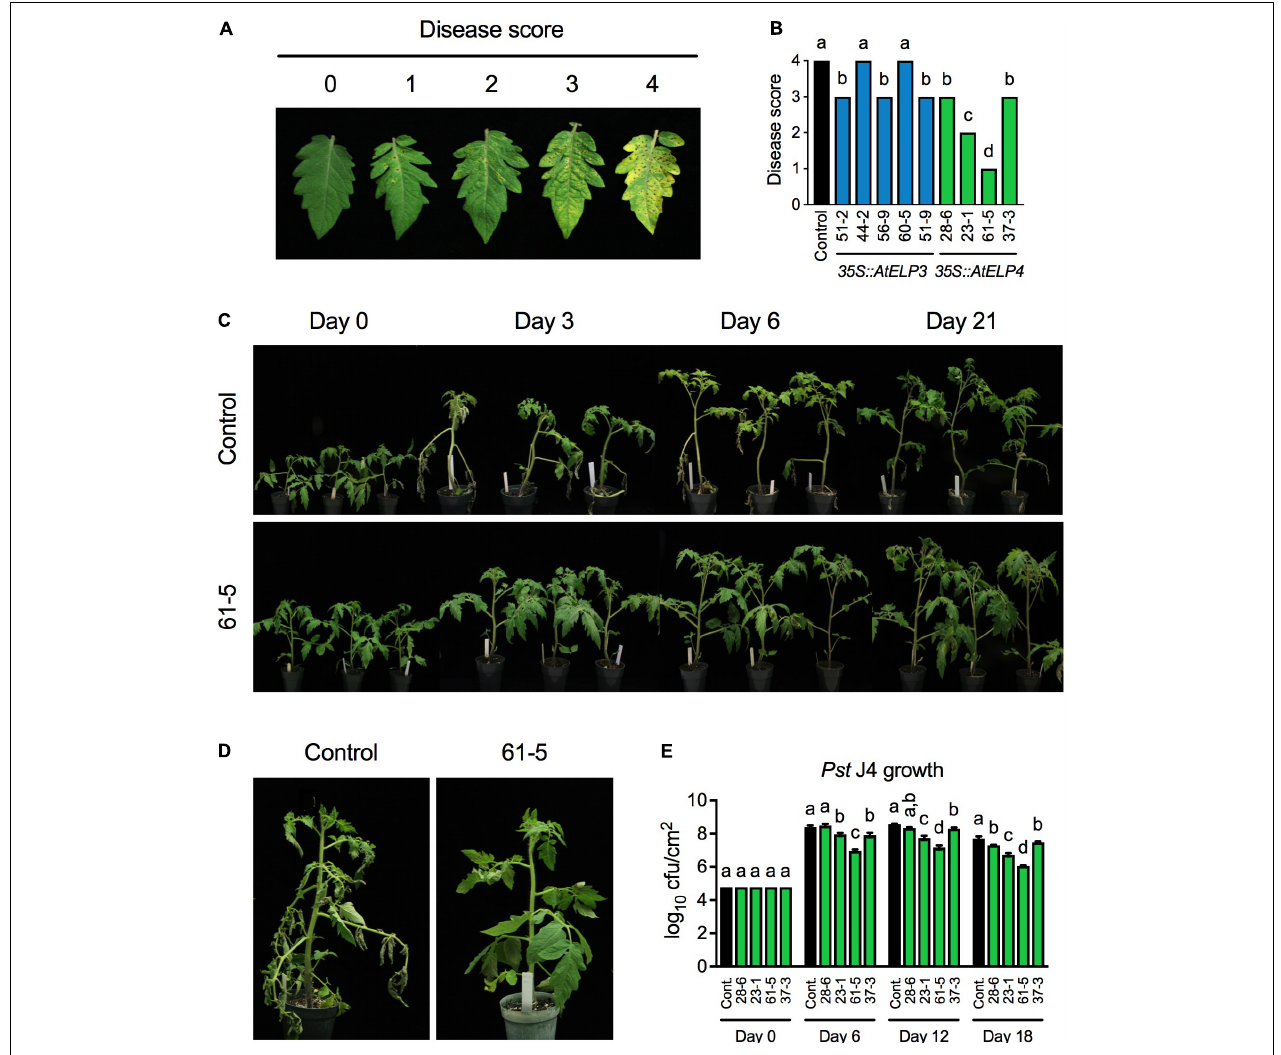
FIGURE 2 | Resistance of the transgenic lines to bacterial speck disease caused by Pst J4. (A) Responses on the leaves to which different disease scores were assigned after spray inoculation with Pst J4. Score 0: no symptoms; Score 1: few slightly visible lesions; Score 2: significant number of discernible lesions; Score 3: higher amount of discernible necrotic and chlorotic lesions; and Score 4: extensive necrotic and chlorotic lesions and extensive dead tissue. (B) Disease scores of bacterial speck disease on five AtELP3 transgenic lines, four AtELP4 transgenic lines, and the control. Data represent the mean of six plants with SD. The disease symptoms on each line were highly uniform and the SD values were 0. Different letters above the bars indicate significant differences (Tukey’s test, P < 0.05). (C) Bacterial speck disease progression on the most resistant transgenic line 61-5 and the control following spray inoculation with Pst J4. (D) Close-up pictures of the most resistant transgenic line 61-5 and the control at 3 days post-inoculation. (E) Bacterial titers in the AtELP4 transgenic lines and the control. cfu, colony forming unit. Data represent the mean of three biological replicates with SD. Different letters above the bars indicate significant differences (Tukey’s test, P < 0.05). Note that the comparison was made separately among the transgenic lines as well the control (cont.) for each time point.